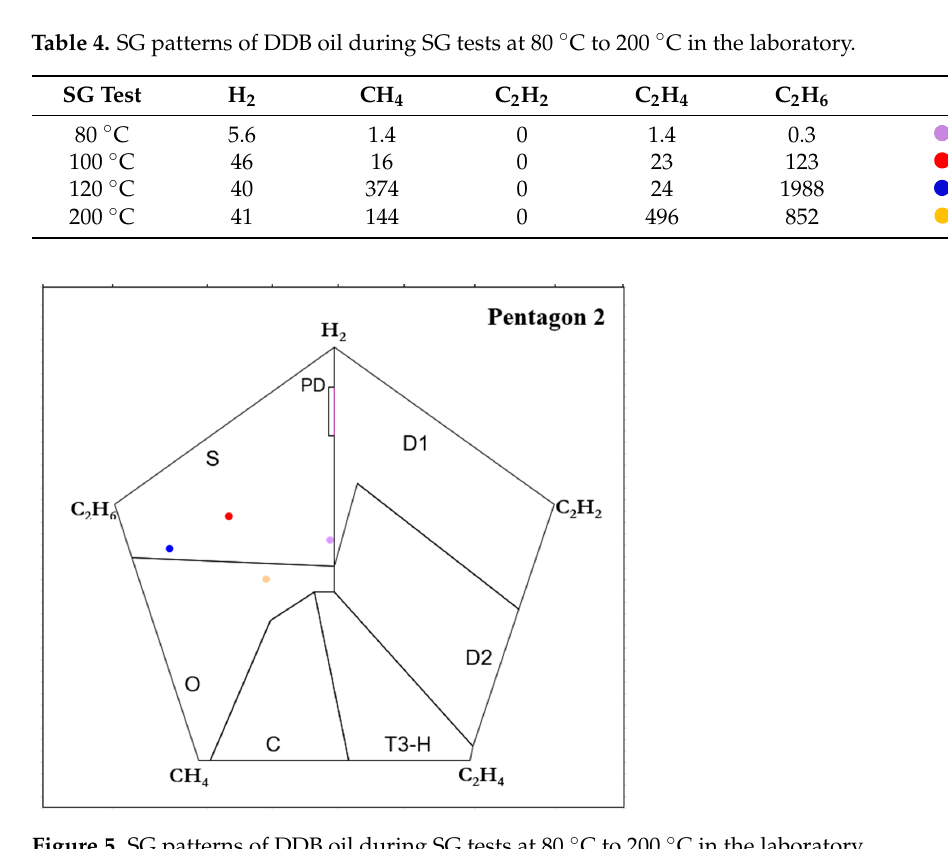
Figure 4. SG patterns of DDB oil in bushings of RWE in service (units 3–4).